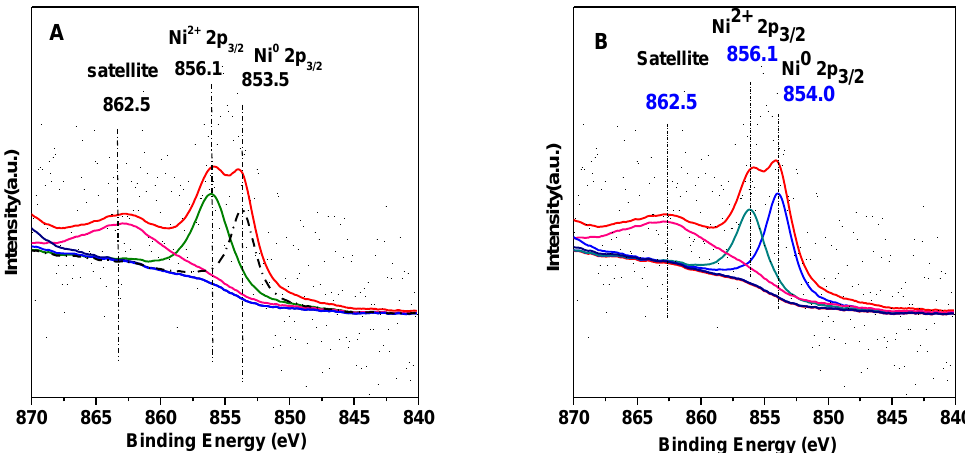
Figure 4. Two representative Ni 2p XPS of ( A ) 5% Ni / AC and ( B ) Ni-Re / AC(n Ni :n Re =